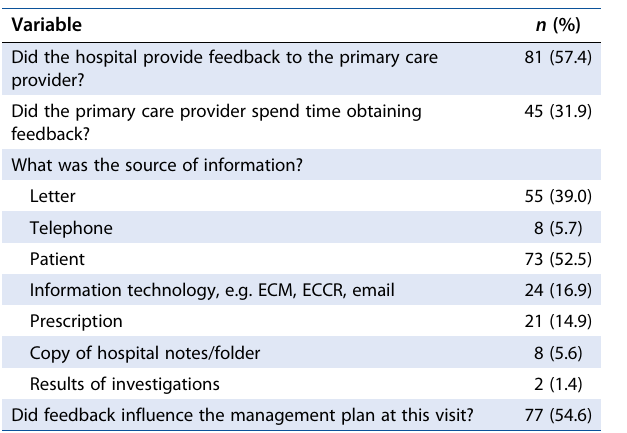
Table 5: Nature of feedback from hospital ( n = 141) Variable n (%)